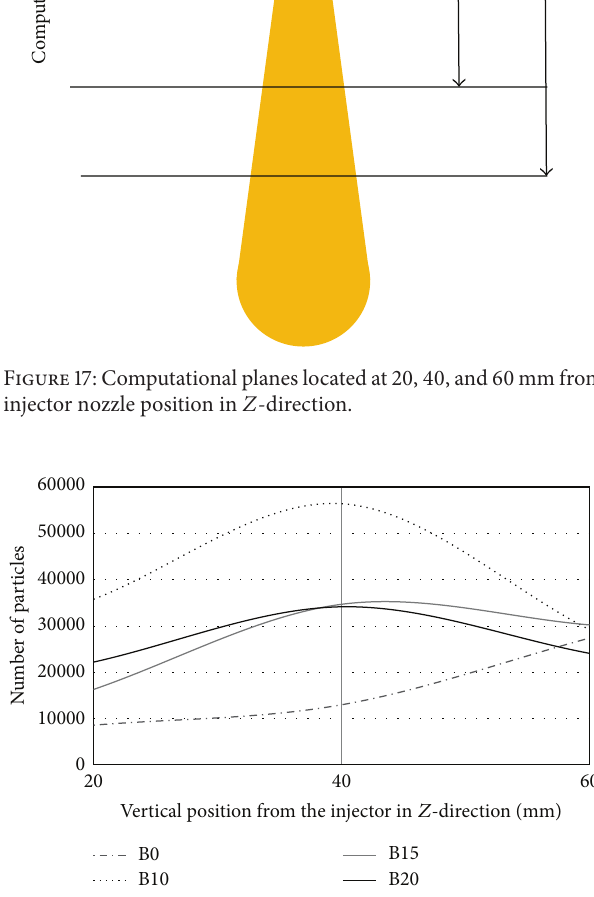
Figure 18: Number of spray particles for different HFO/n-butanol blends at injection pressure of 600 bar on different vertical positions from the injector.